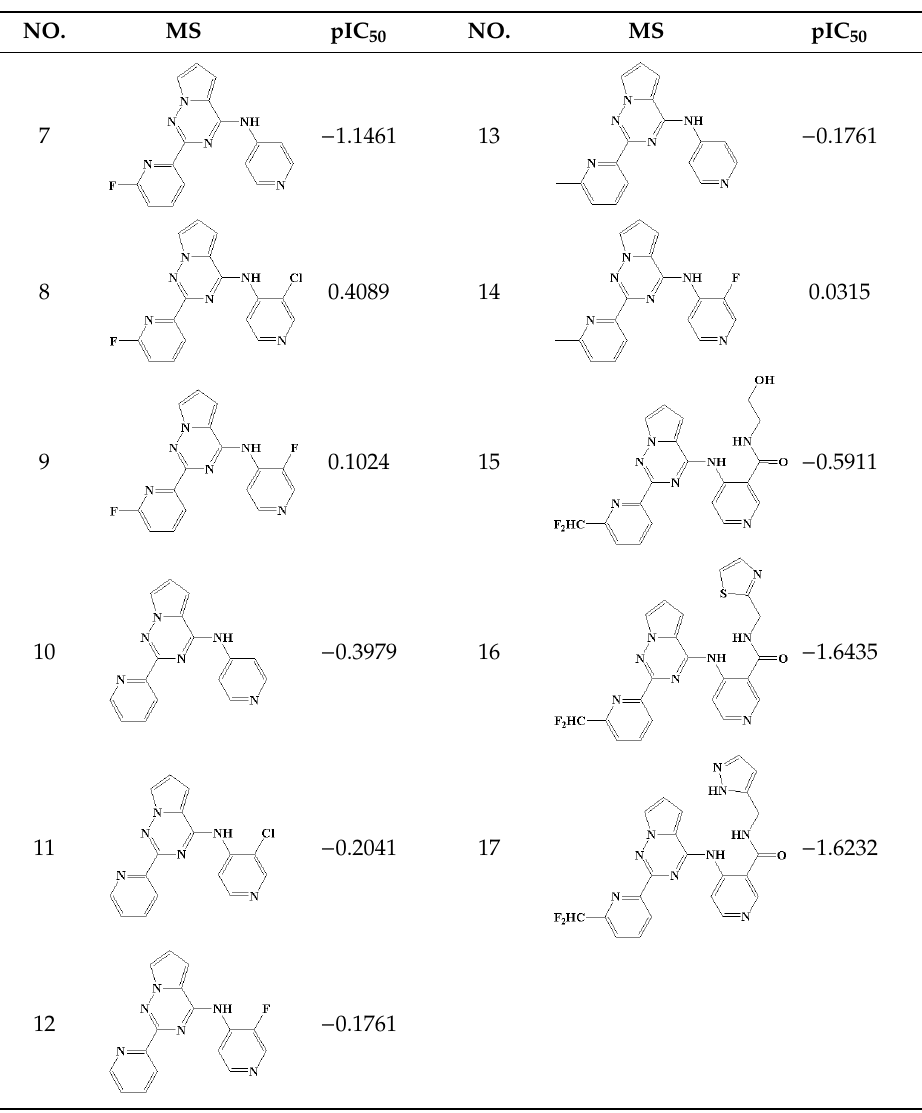
Figure 5. The binding modes of Compounds 7, 8, and 9 at the active site (amino acid residue